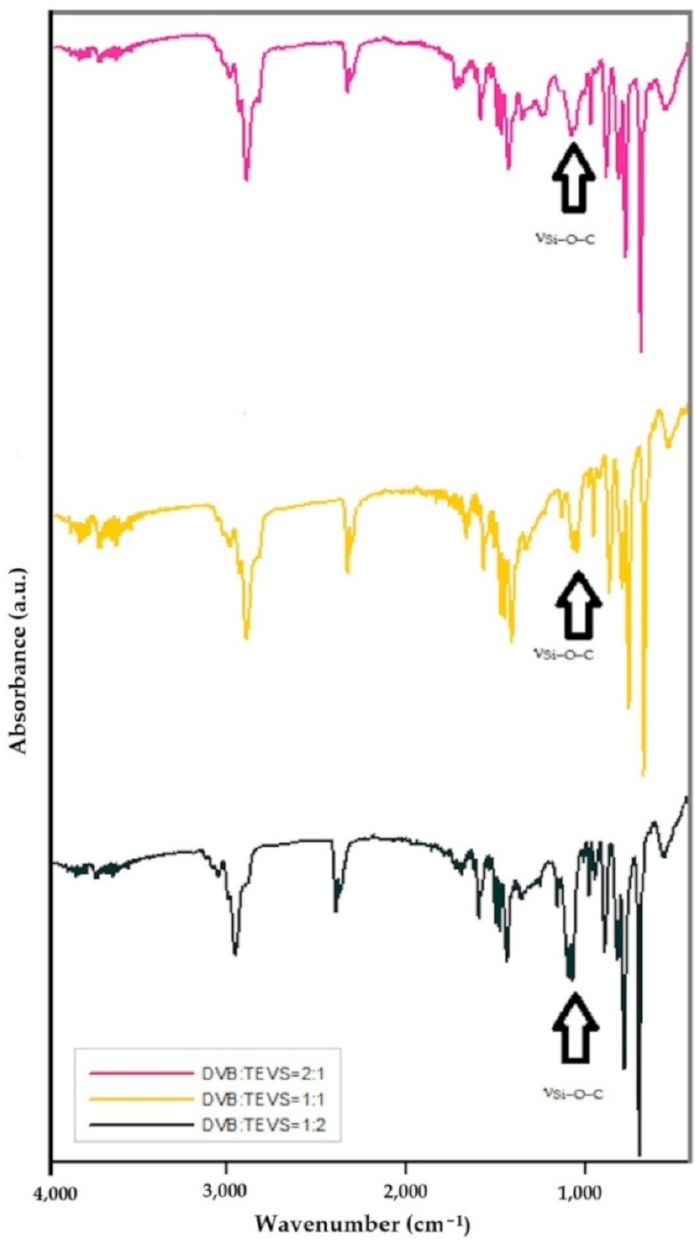
Figure 2. FTIR/ATR spectra for DVB:TEVS materials with phase ratios: 2:1, 1:1 and